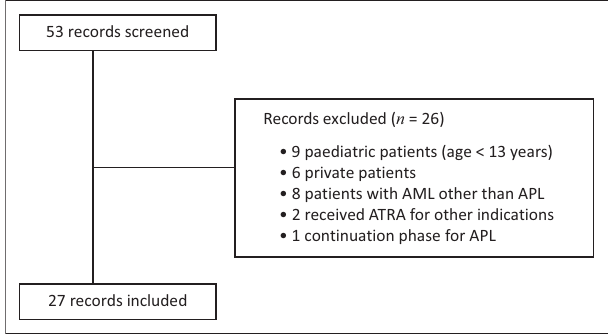
FIGURE 1: Selection of records included in the study.